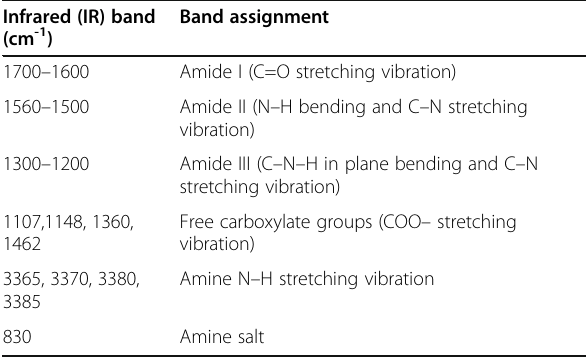
Table 1 Infrared band assignment of silk sericin (SS), AgNO 3 ,